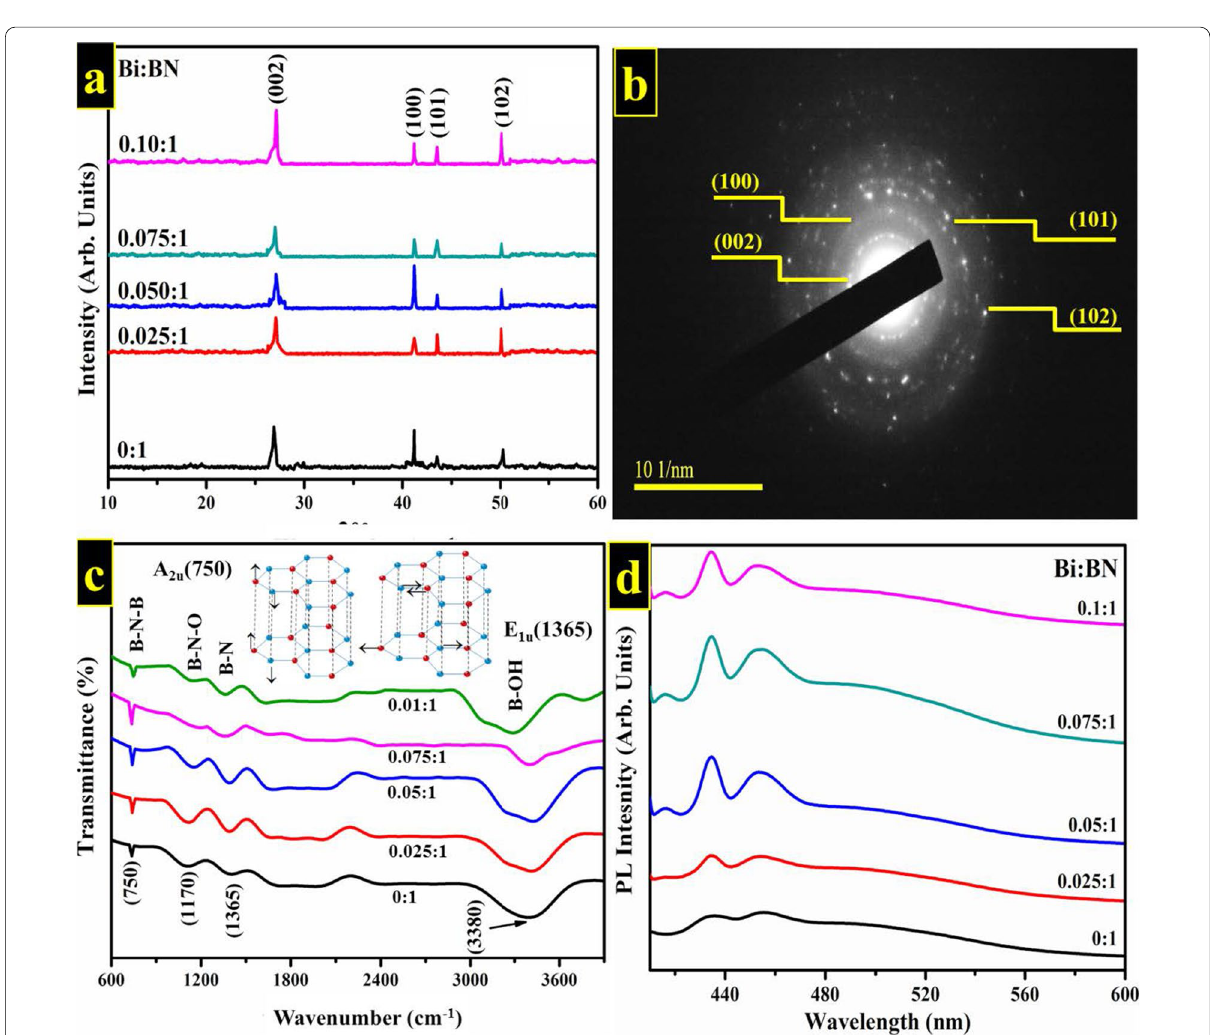
Fig. 2 a XRD patterns of host and Bi‑doped BN nanosheets with various concentrations (2.5, 5, 7.5 and 10 wt%); b SAED pattern obtained from BN nanosheets; c FTIR spectra; d PL